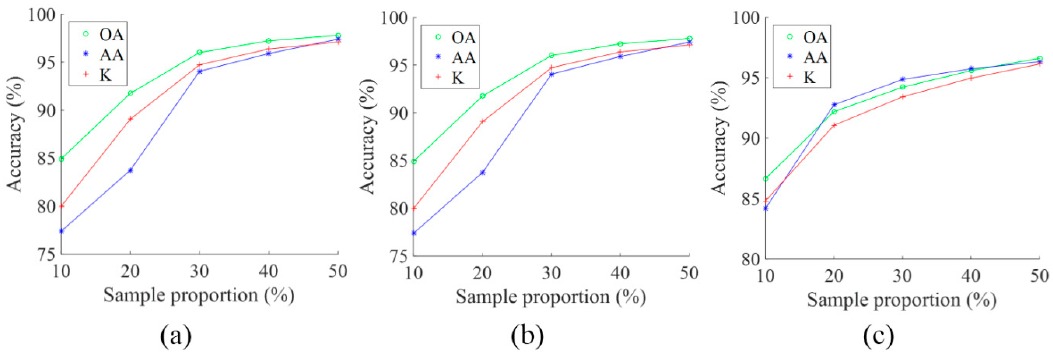
Figure 16. Influence of sample proportion. ( a ) Pavia University scene; ( b ) Botswana scene; ( c ) Indian Pines scene.